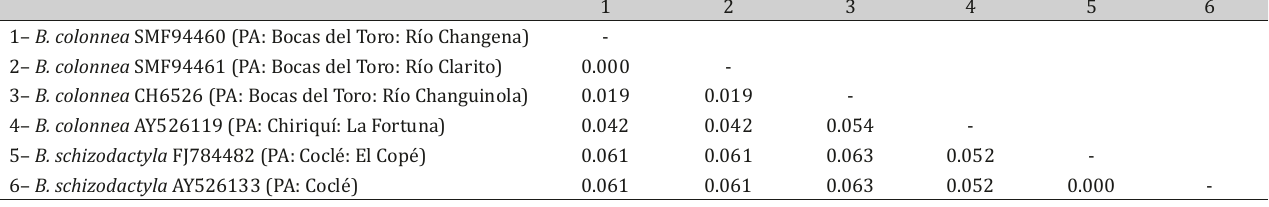
has been chosen as